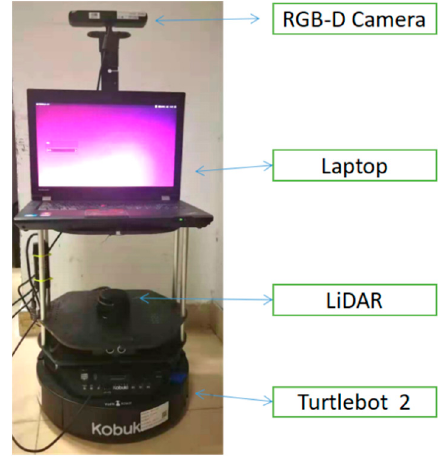
Figure 6. The robot platform for the experiment.